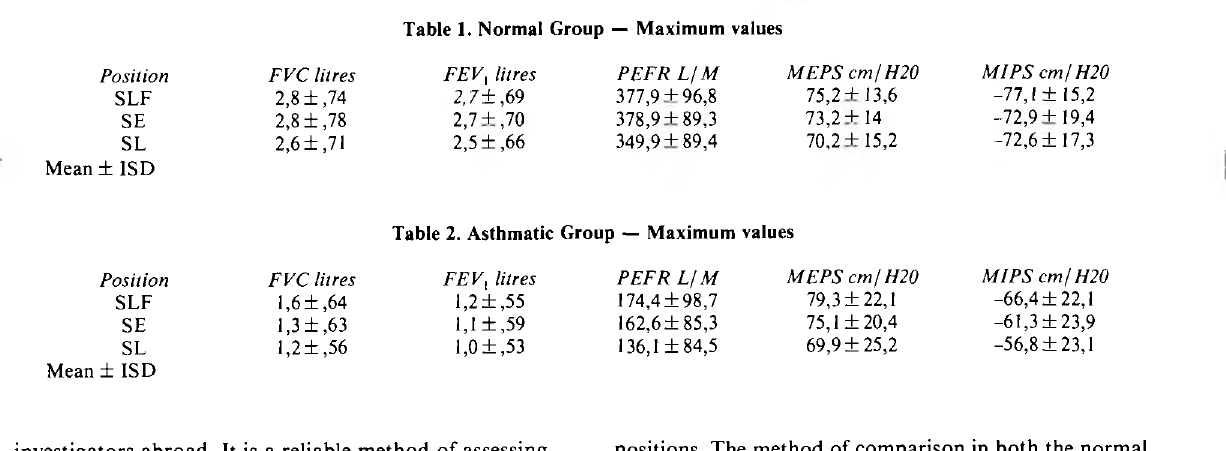
Table 2. Asthmatic Group — Maximum